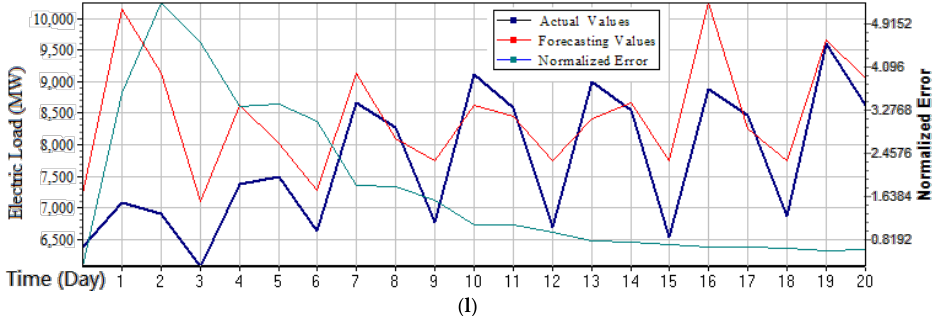
Figure 3. Forecasting results for small sample (from January to December). ( a ) January; ( b ) February; ( c ) March; ( d ) April; ( e )May; ( f ) Jun; ( g ) July; ( h ) August; ( i ) September; ( j ) October; ( k ) November; ( l ) December.